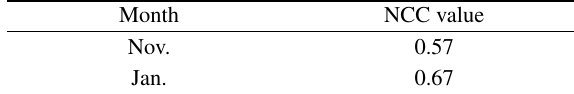
Table 10 NCC value between the English tweets (classified as self) and count of actual hospital visits.